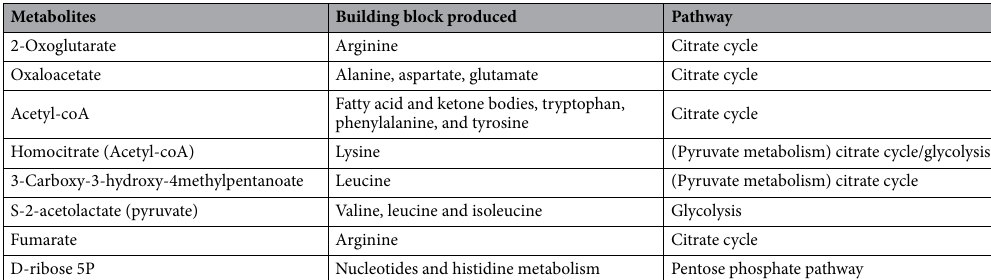
Metabolites Building block